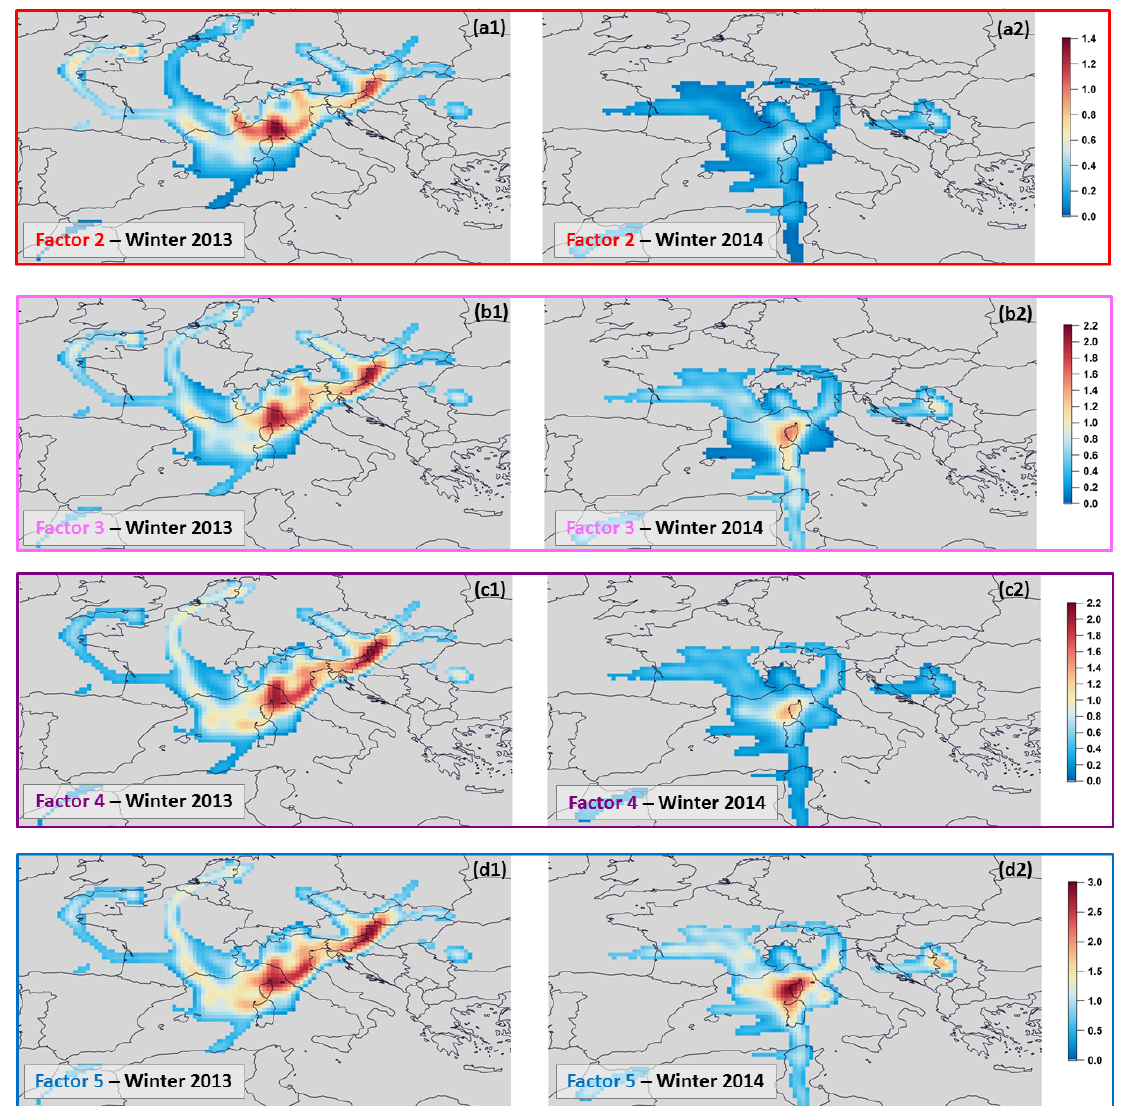
Figure 12. Potential source area contributions to NMHC anthropogenic sources during winters 2013 and 2014. Contributions are expressed in µgm − 3 . Factor 2 – short-lived anthropogenic sources; factor 3 – evaporative sources; factor 4 – long-lived combustion sources; factor 5 – regional background. Winter: 1 January–31 March